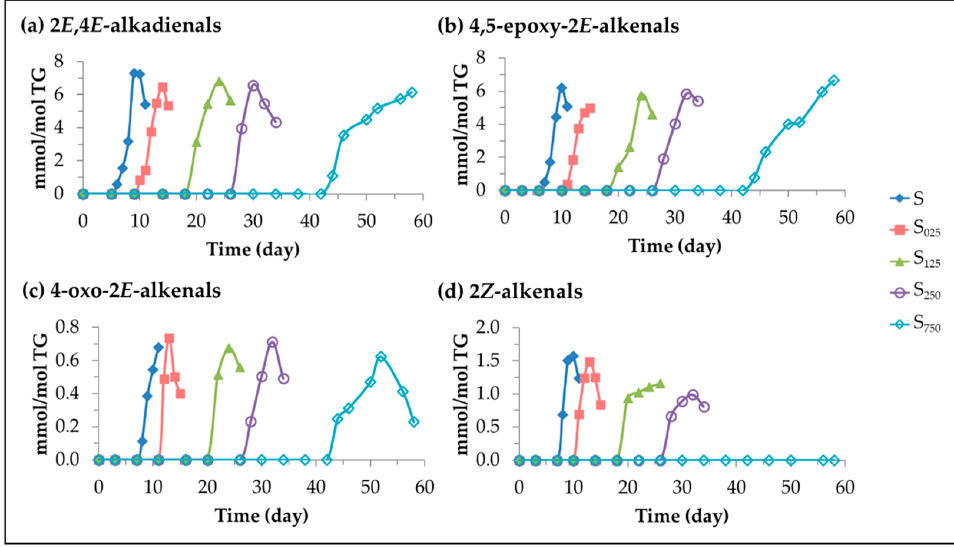
Figure 13. Evolution of the concentration, expressed in mmol/mol TG, in samples S, S 025 , S 125 , S 250 and S 750 throughout the storage at 70 °C up to a very advanced oxidation stage, of: ( a ) 2 E ,4 E -alkadienals; ( b ) 4,5-epoxy-2 E -alkenals; ( c ) 4-oxo-2 E -alkenals; and ( d ) 2 Z -alkenals.